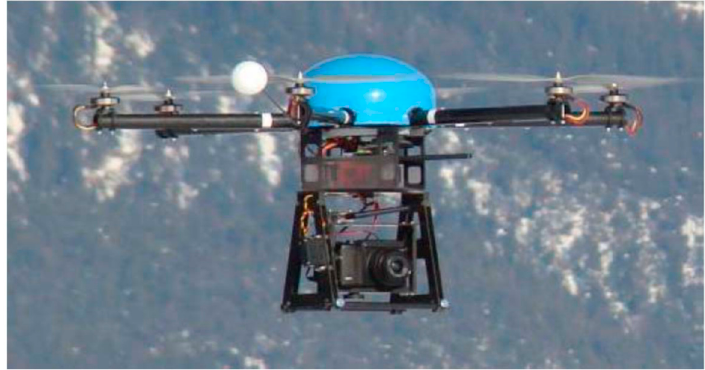
Figure 5. Designed UAV by S. Meivel